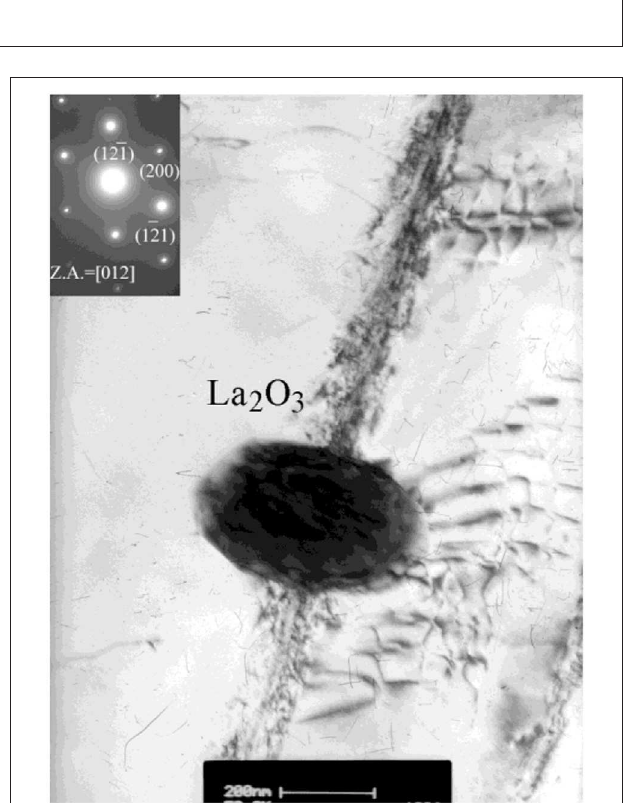
FIGURE 13 | Bright field TEM microscopy and diffraction pattern of La 2 O 3 particles after creep at 923K, 300 MPa.